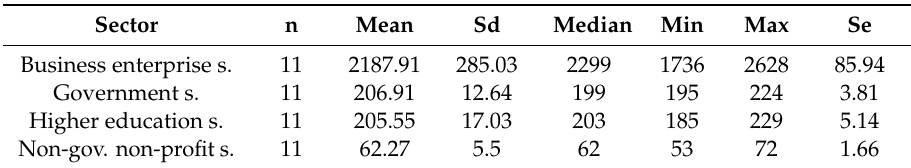
Table 2. Descriptive statistics of each sector.